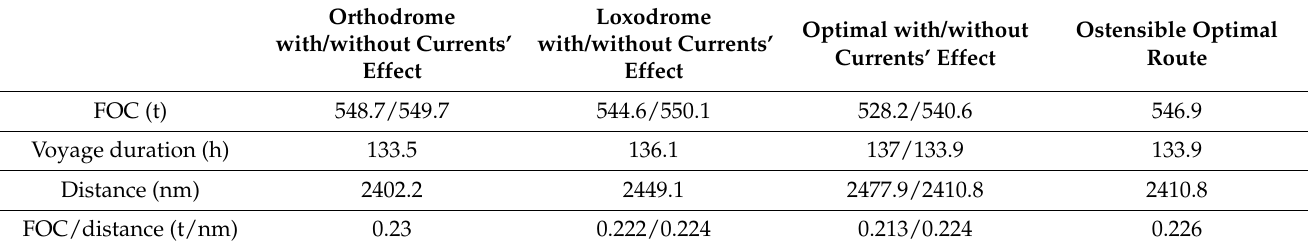
Table 5. Paths for heavy hull fouling conditions (Case